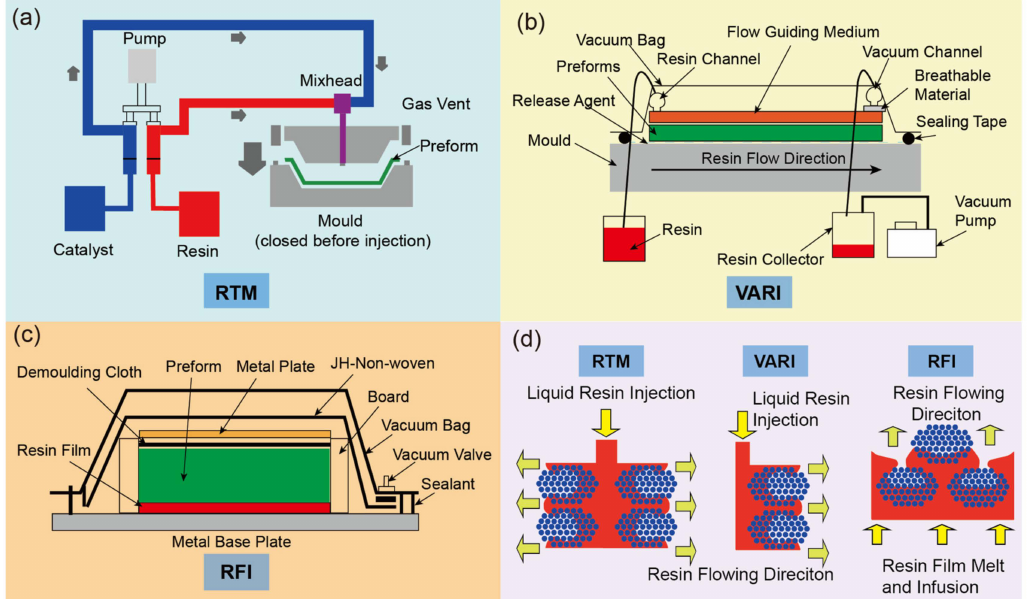
Figure 6. Three liquid composite molding processes. ( a ) RTM, the mold is closed during the injection of resin; ( b ) VARI, an open mold and vacuum bag are used; ( c ) RFI, resin film is used to infuse the preform; and ( d ) Direction of resin flow in the three